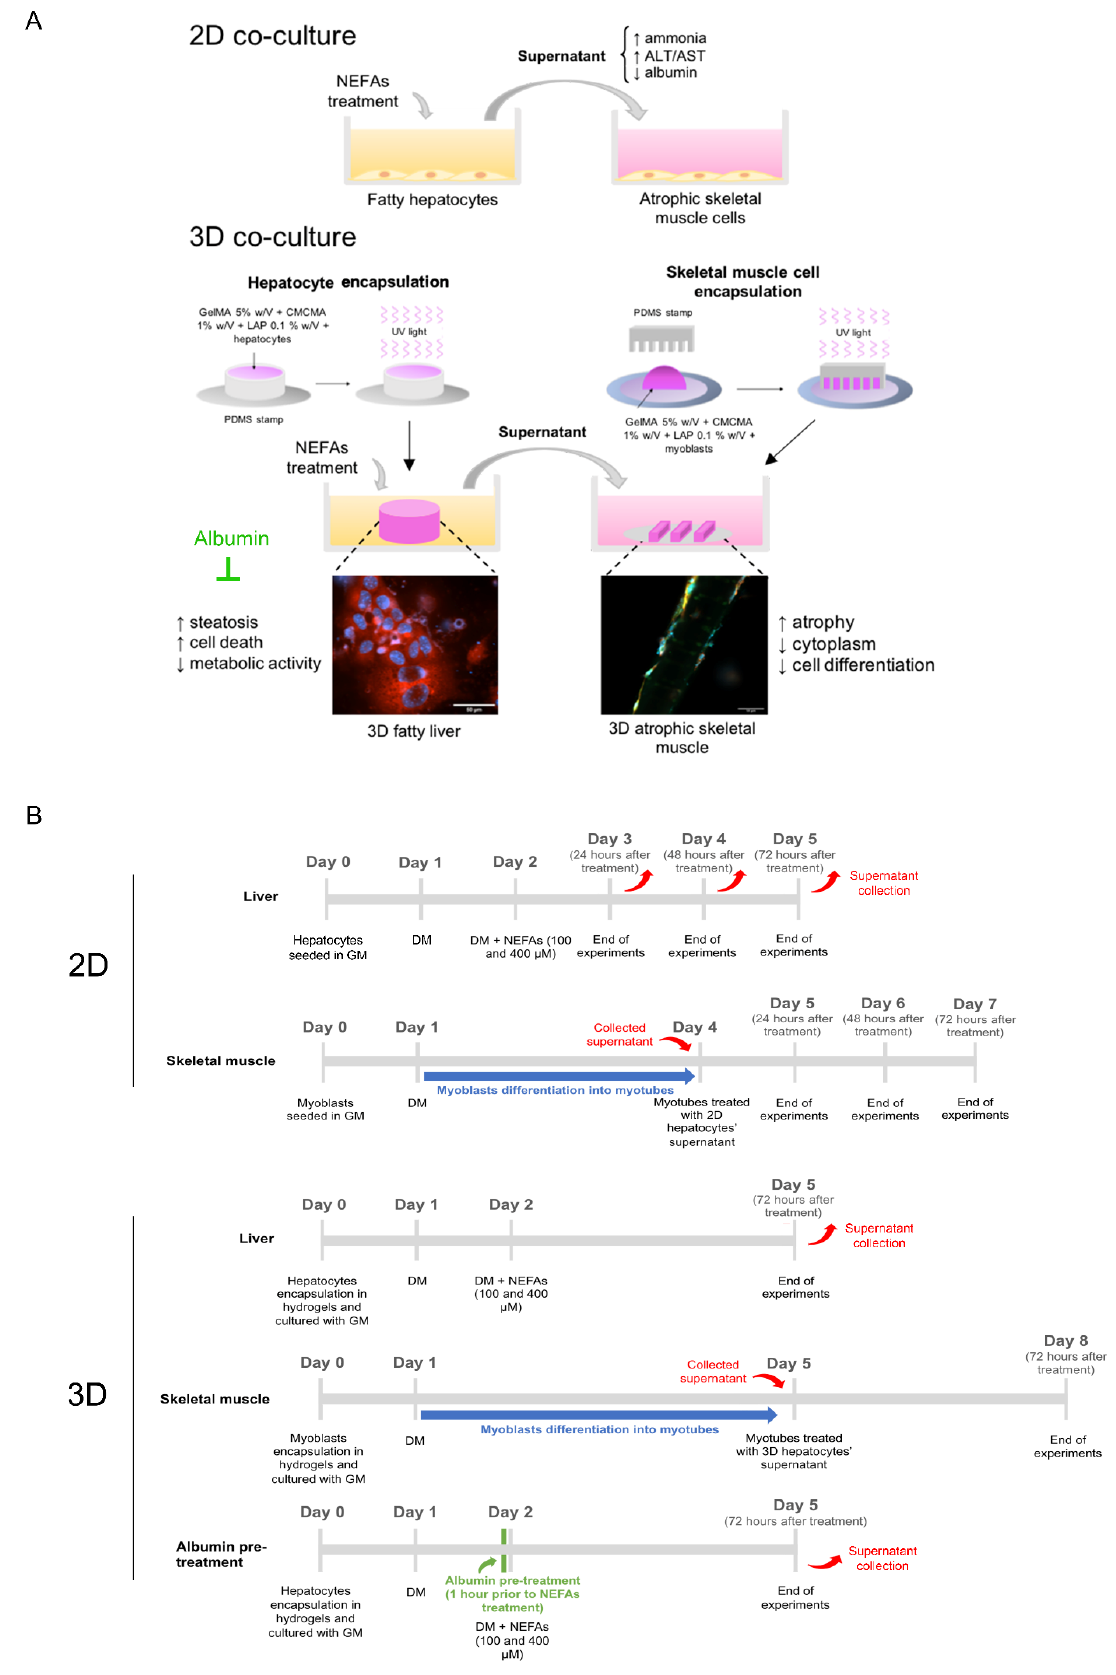
Figure 1. ( A ) Schematic representation of the in vitro experimental model employed in this